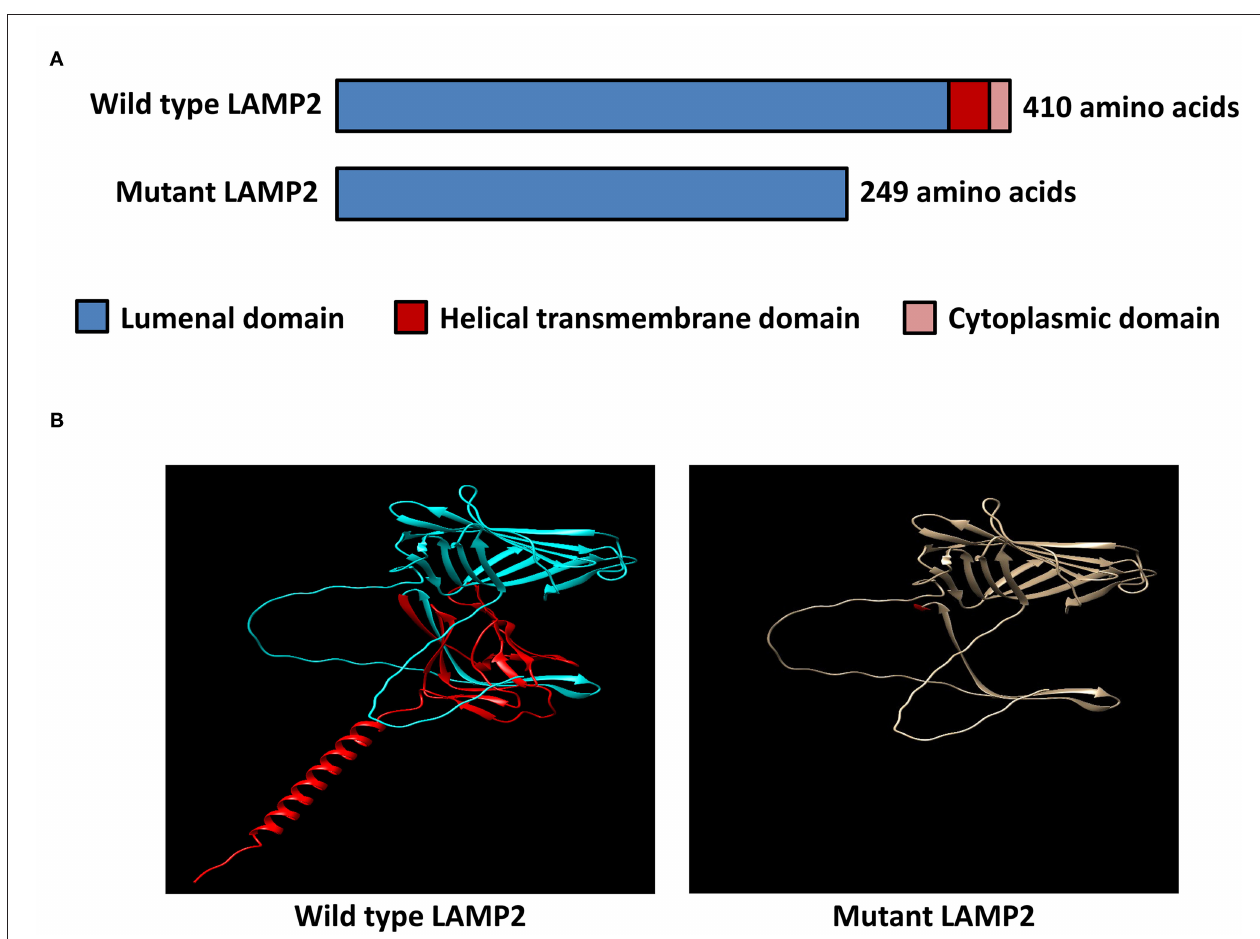
FIGURE 3 | In-silico structural modeling of the identified mutation. (A) Schematic diagram of the wild-type LAMP2 protein and the mutant truncated LAMP2 protein. (B) Protein structural modeling of the wild-type and mutant LAMP2